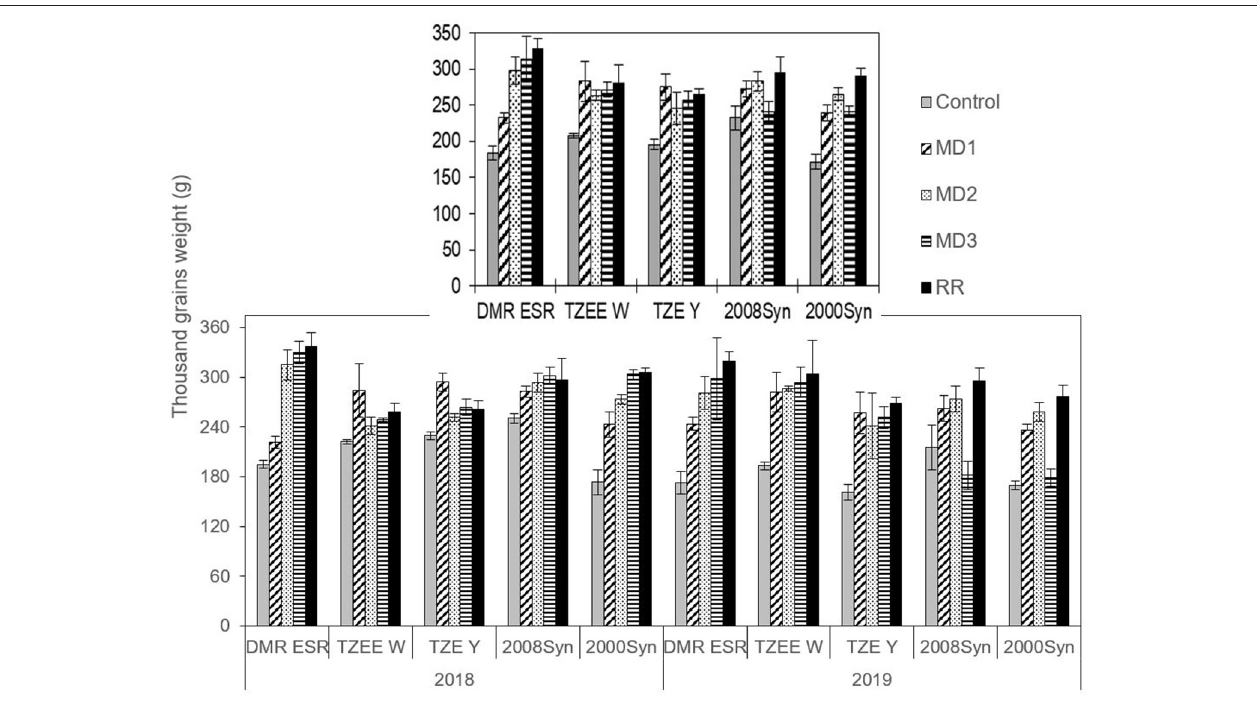
FIGURE 6 | Thousand grains weight (TGW) as affected by the interactions between year, variety, and mineral fertilizer. Control refers to the absolute unfertilized treatment; MD1 (N25P4), MD2 (N25P8), MD3 (N35P8), and RR (N76P13) refer to fertilizer microdosing options 1, 2, and 3 and the recommended fertilizer rate, respectively. Error bars represent standard deviations. HI, harvest index; TGW, thousand grains